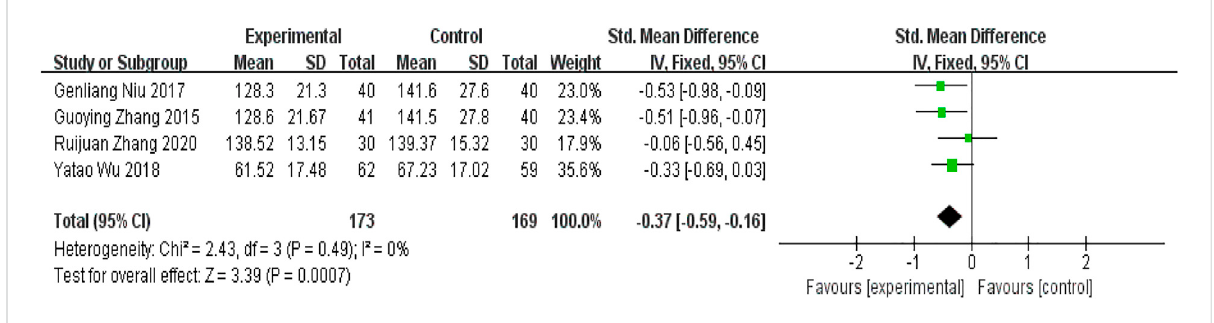
FIGURE 10 Forest plot for peak systolic blood fl ow velocity.